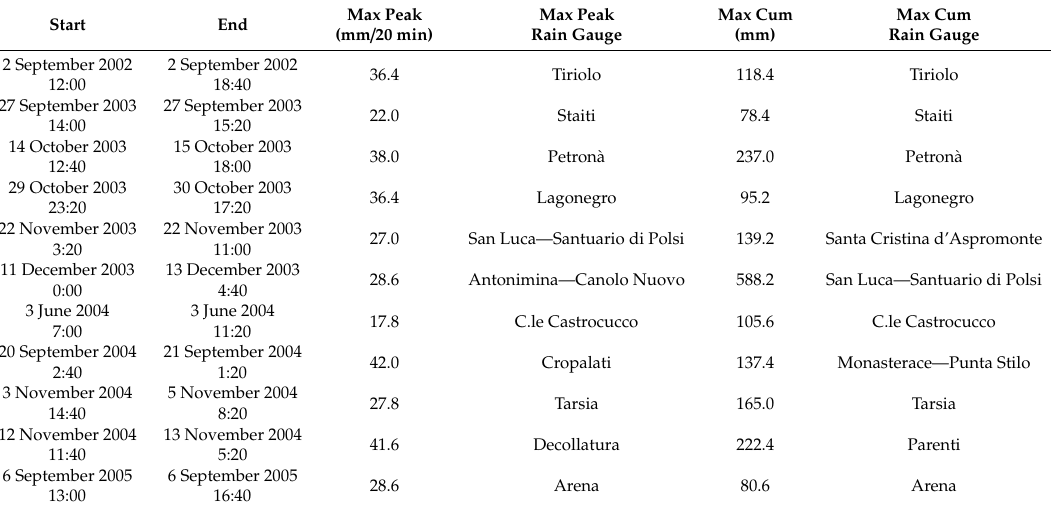
Table A1. List of the selected Most Heavy Rain (MHR)